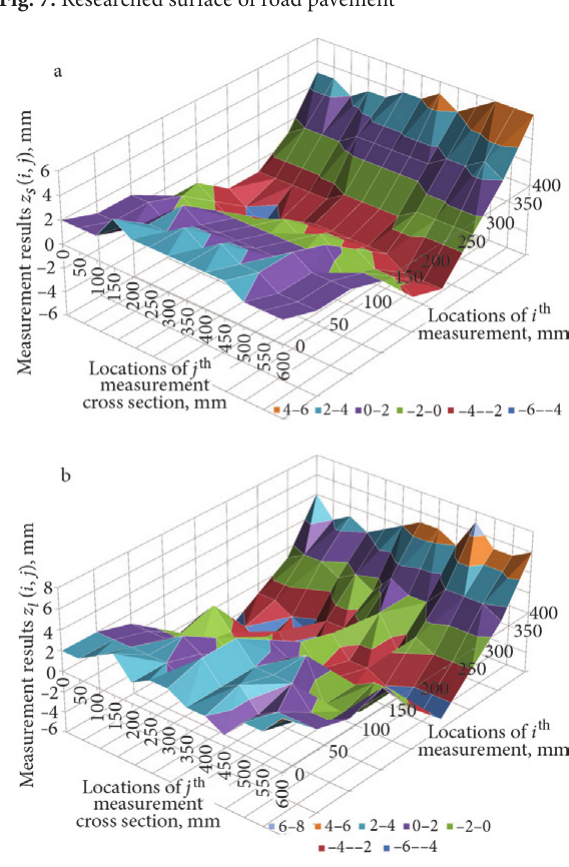
Fig. 8. Sample grid of measurements from: a – stereo vision method; b – laser distance meter